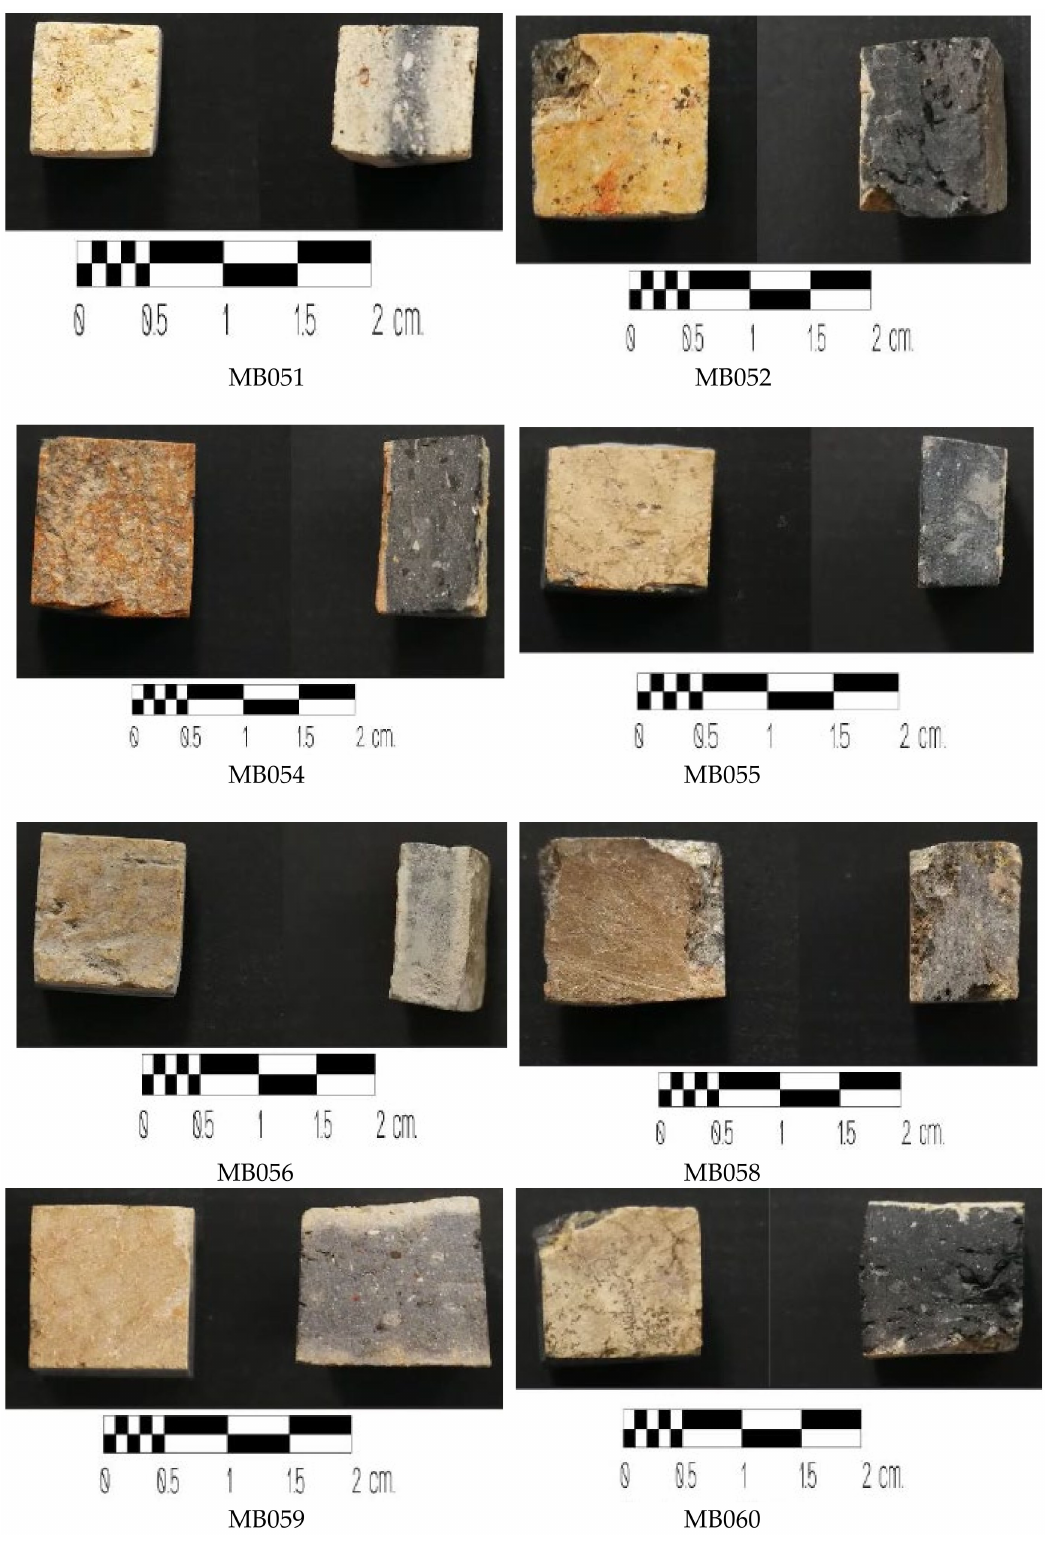
Figure 3. Top view ( left ) and cross-sectional ( right ) images of MB051, MB052, MB054, MB055, MB056, MB058, MB059, and